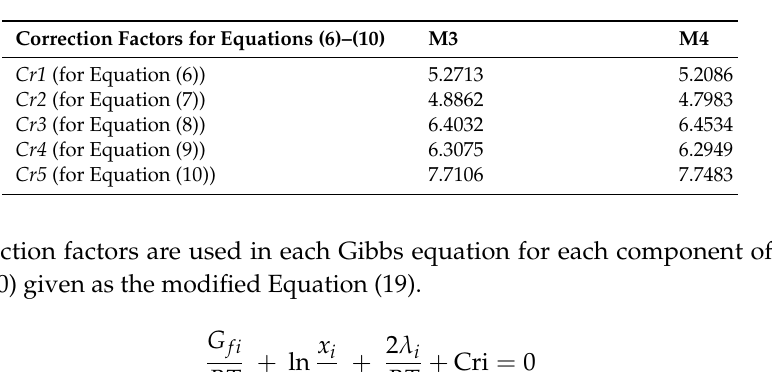
Table 5. Correction factors for the Models M3 and M4.